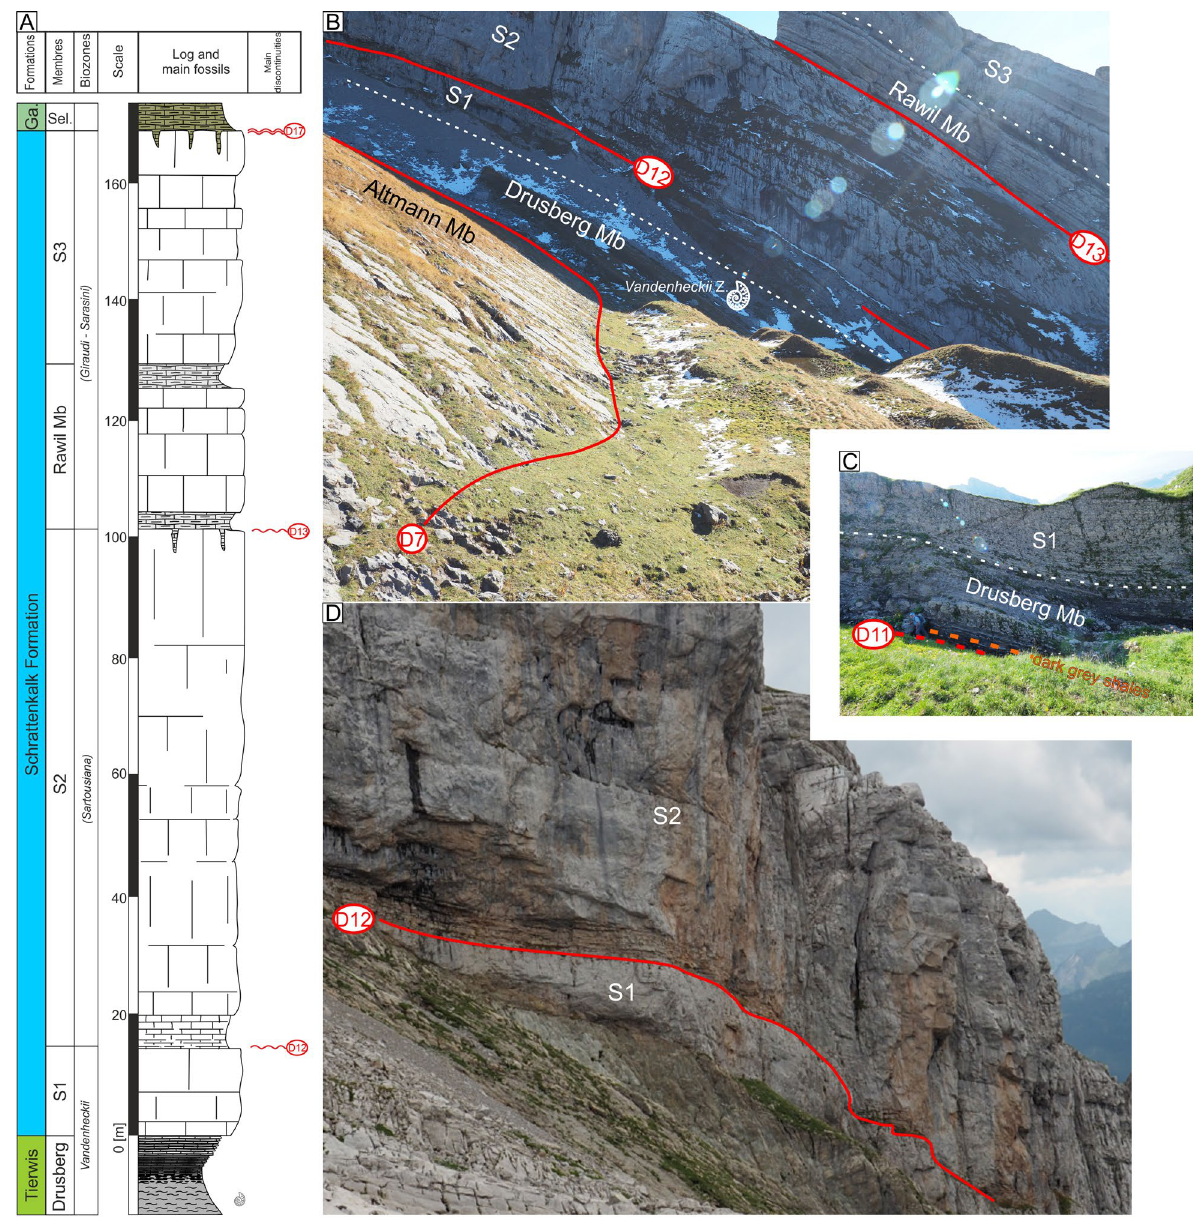
Fig. 9 A Langtal-Säntis section. Lithological log with discontinuity surfaces (D12 to D17). B Overview of the section looking north eastward. C Focus on the Drusberg-Schrattenkalk transition at Langtal. D Focus on the boundary between units S1 and S2 characterised by thin-bedded bioclastic limestones, which form the base of unit